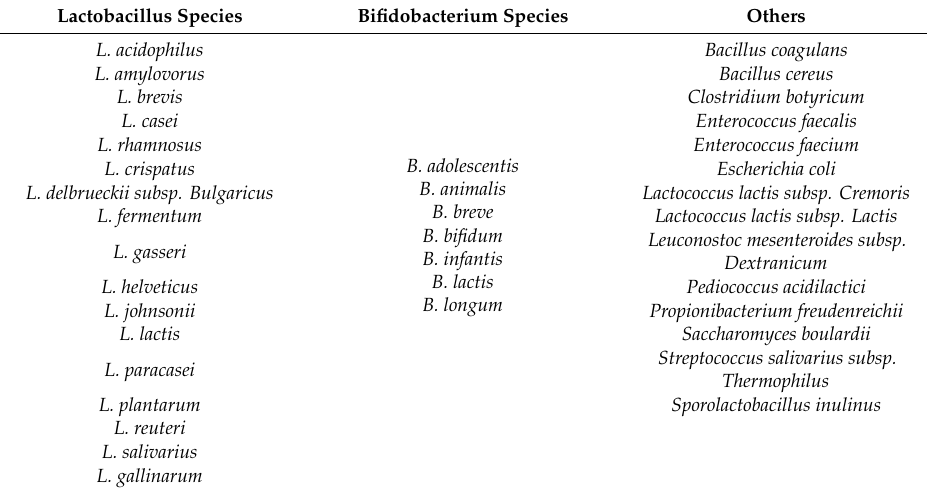
Table 1. The most widely used probiotics in the food industry.